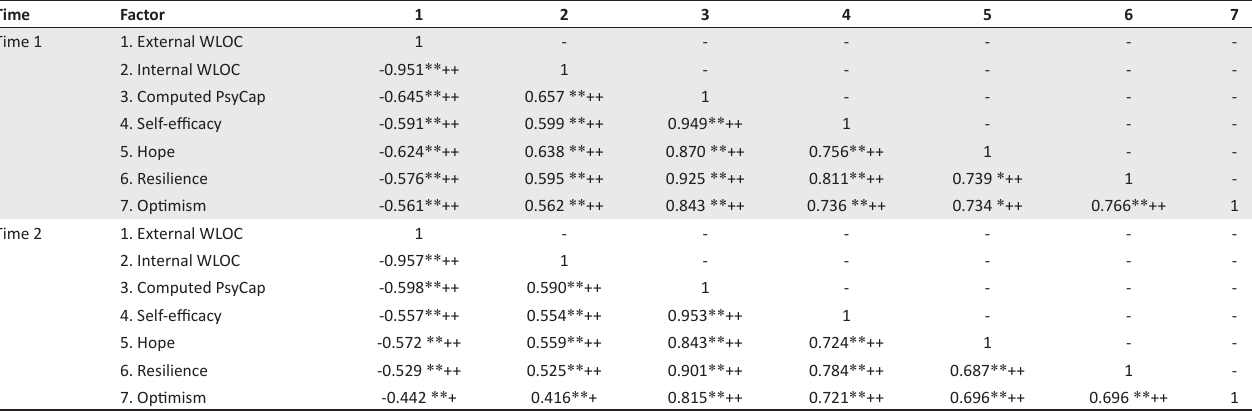
TABLE 3: Pearson correlations between the scales and factors for Time 1 and Time 2.